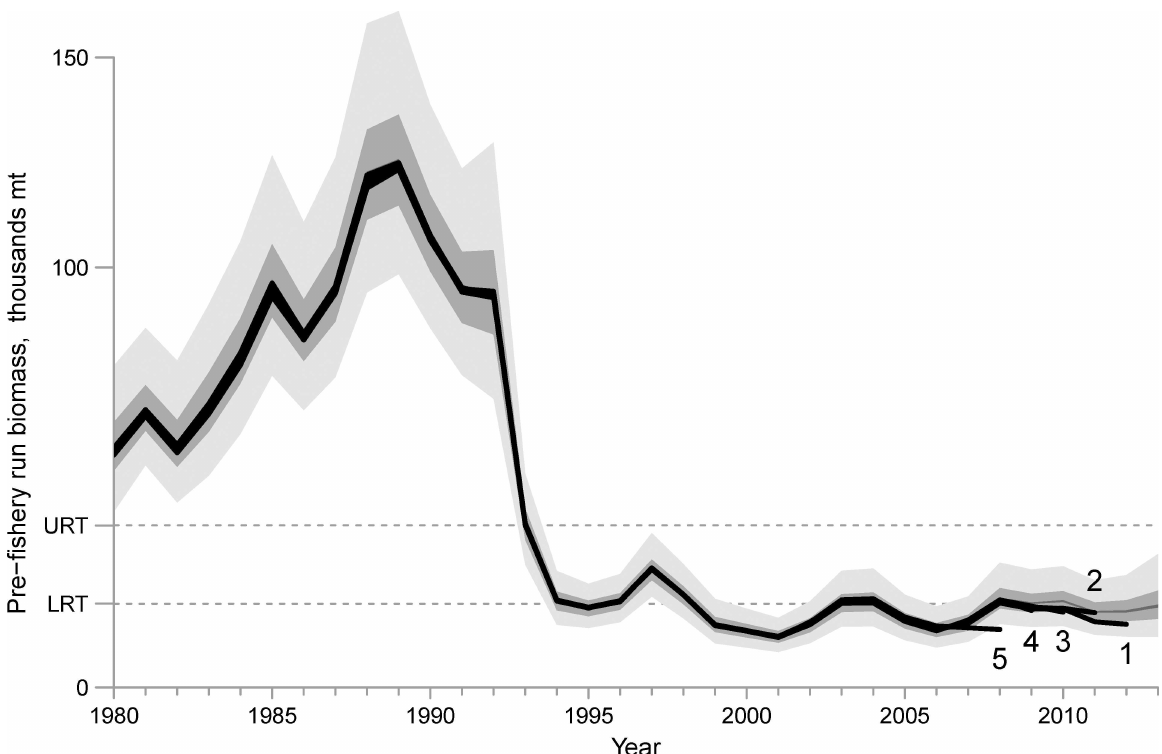
Fig 12. Results from five retrospective “peels” compared to the posterior intervals (light gray = 95% interval, darker gray = 50% interval, black = 5% interval) of pre-fishery run biomass from the Bayesianmodel fit to the entire time series of data. Each “peel” is the posterior medianof the model run with an additionalyear of data removedand is labelednumerically where a highernumber denotesa peel of data further into the past.